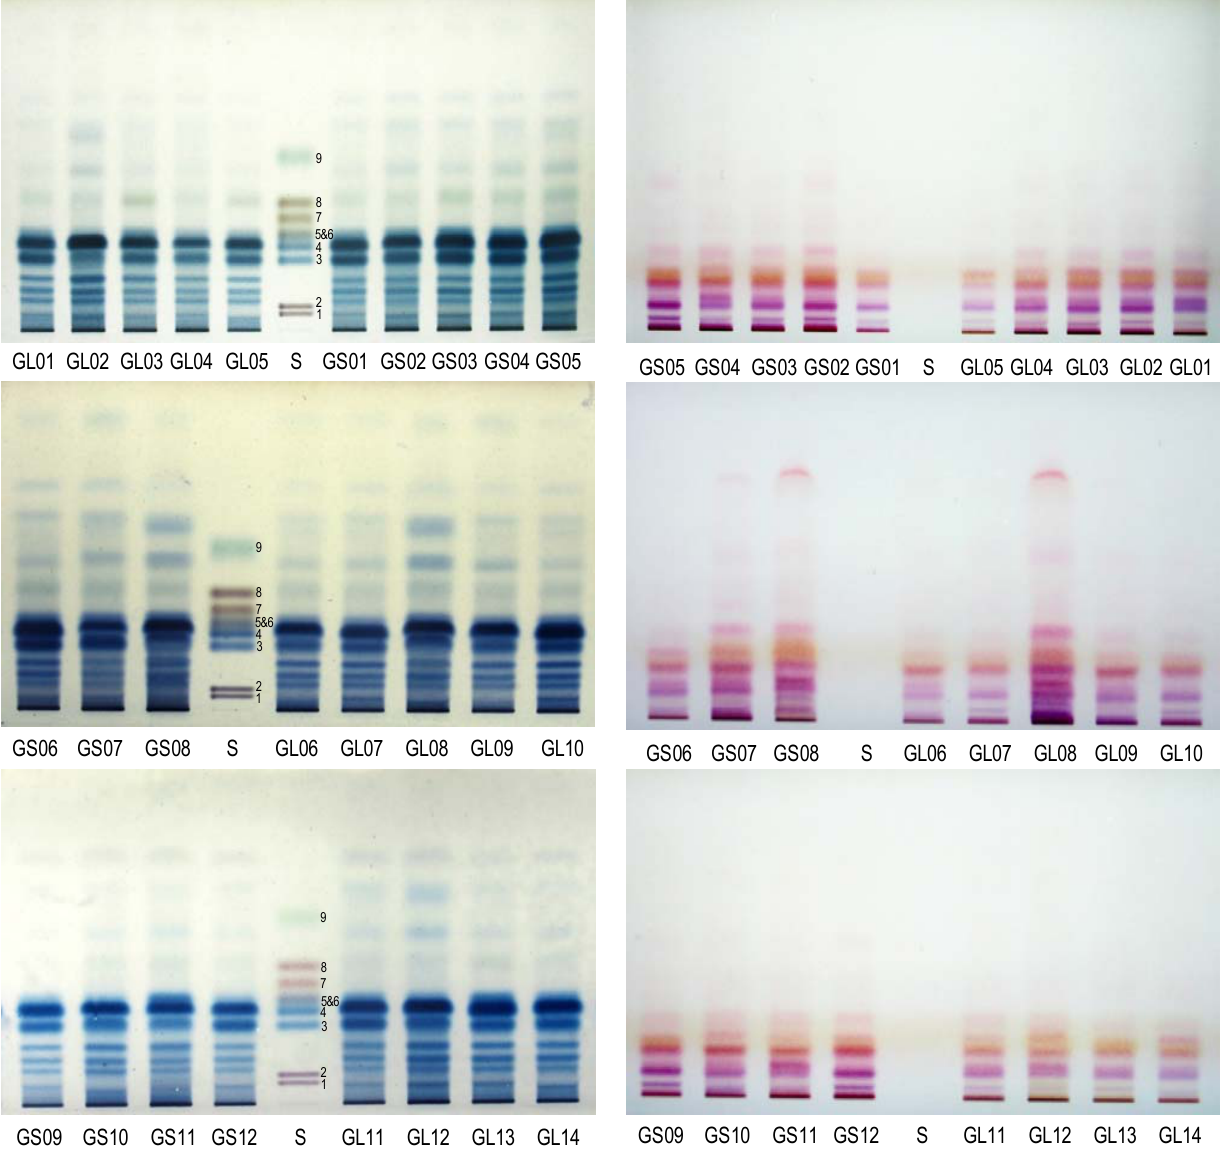
Figure 5. HPTLC profiles, colored with aniline-diphenylamine-phosphoric acid (Left) and ninhydrin (Right) solutions, of acid hydrolysates of polysaccharides from Linzhi . GL01-GL14 and GS01-GS12 were the same as in Section 3.1. S : Mixed standards of D -galacturonic acid ( 1 ), D -glucuronic acid ( 2 ), D -galactose ( 3 ), D -glucose ( 4 ), D -mannose ( 5 ), L -arabinose ( 6 ), D -xylose ( 7 ), D -ribose ( 8 ) and L -rhamnose ( 9